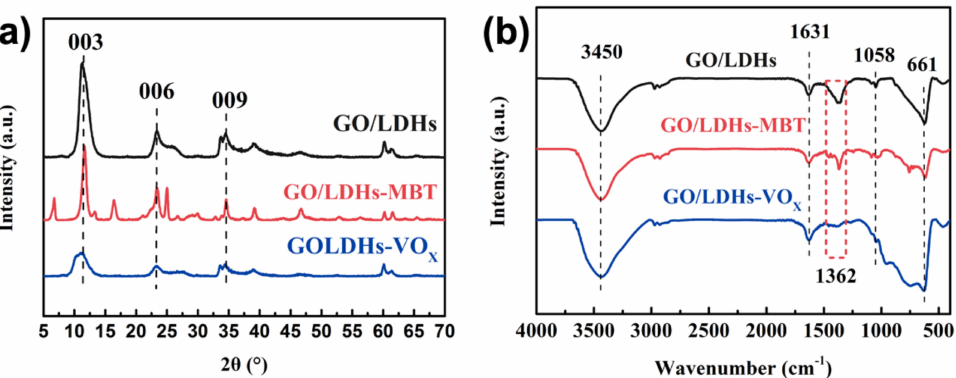
Figure 2. ( a ) X-ray diffraction (XRD) spectra and ( b ) Fourier transform infrared spectrometer (FTIR) spectra of GO/LDHs, GO/LDHs-MBT, and GO/LDHs-VO x .